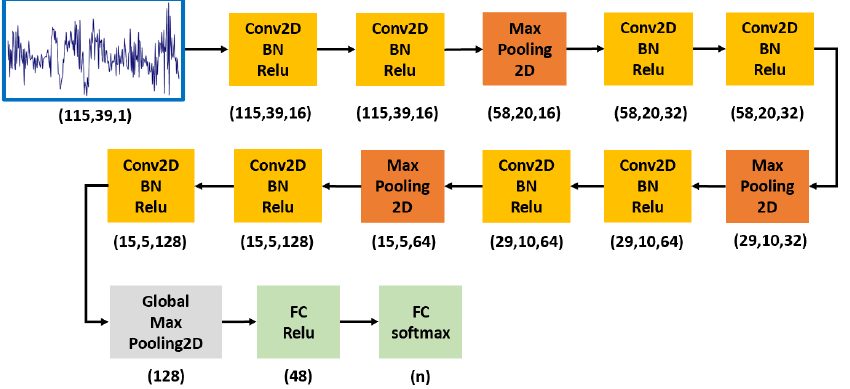
Figure 4. A 2D CNN model for ASR. Numbers in parentheses mean data shapes. For example, (115,39,1) indicates 115 (vectors)